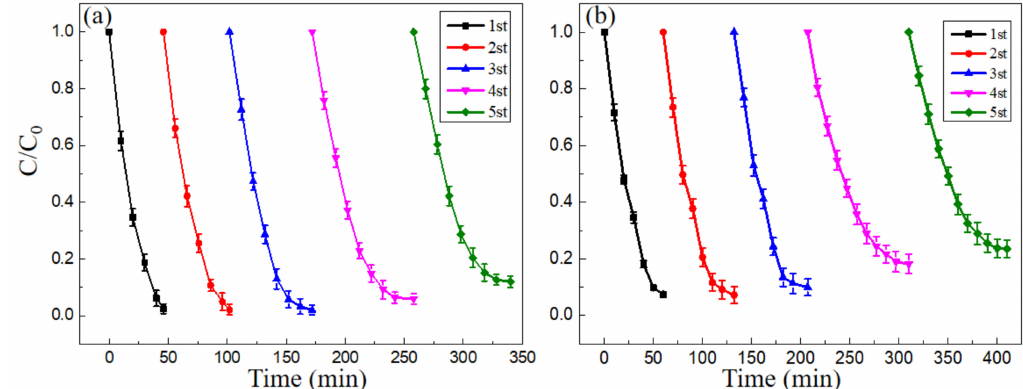
Figure 11. Reusability of nano-PAA-CuCl 2 composite for Fenton-like reaction with MB ( a ) and MO ( b ). Reaction conditions: initial H 2 O 2 concentration 18 mM for MB and 23 mM for MO, initial pH value 3, catalyst synthesized with 8 × 10 − 4 mol/L CuCl 2 solution, 30 ◦